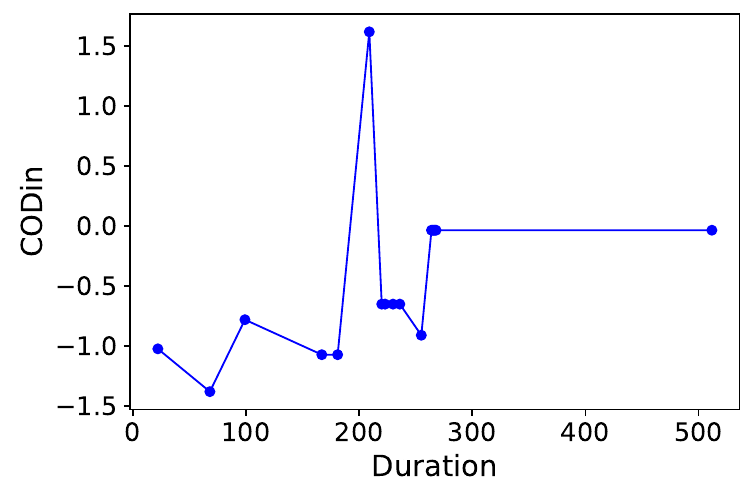
Figure A20. Normalized chemical oxygen demand for Reactor